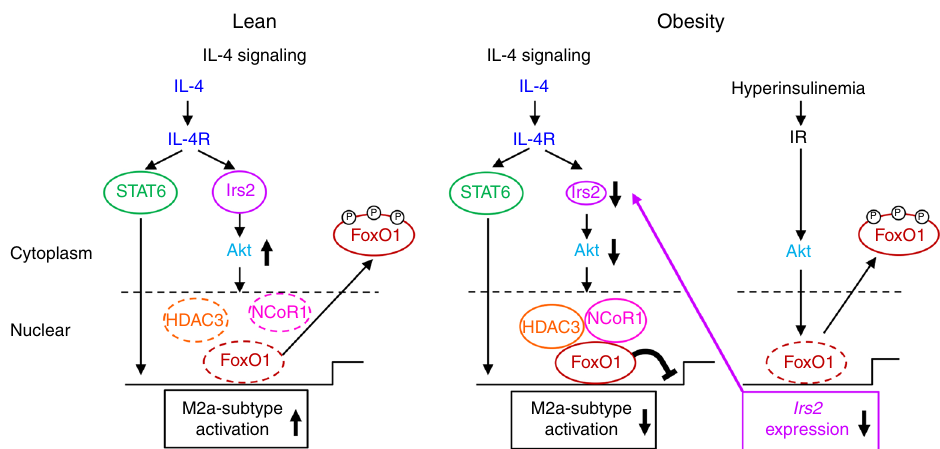
Fig. 7 Scheme illustrating the mechanism of impaired IL-4-induced M2a-subtype M Φ activation in obesity. IL-4/Irs2/Akt pathway was essential for activation of M2a-subtype M Φ s, in addition to IL-4/STAT6 pathway. Both pathways were necessary for the full activation of M2a-subtype M Φ s (left panel). In obesity, although IL-4/STAT6 pathway was maintained, IL-4/Irs2/Akt pathway was selectively impaired along with decreased Irs2 expression and stabilization of the FoxO1/HDAC3/NCoR1 corepressor complex in M Φ s (right